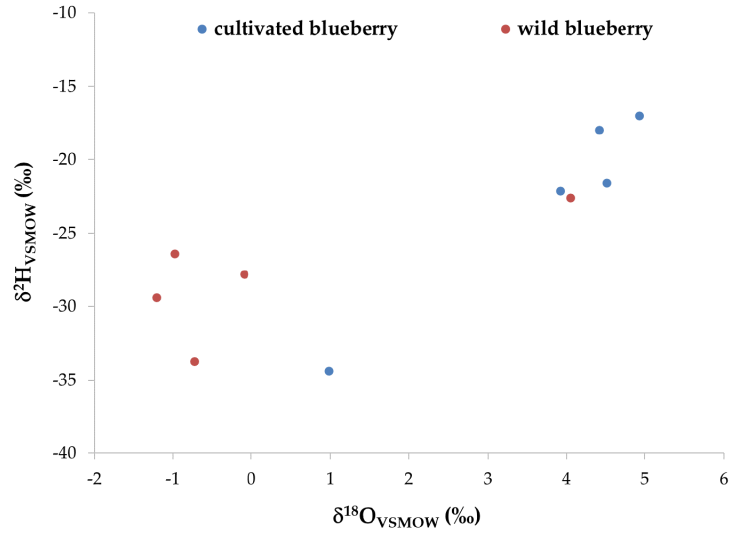
Figure 3. δ 2 H versus δ 18 O for the studied berries.